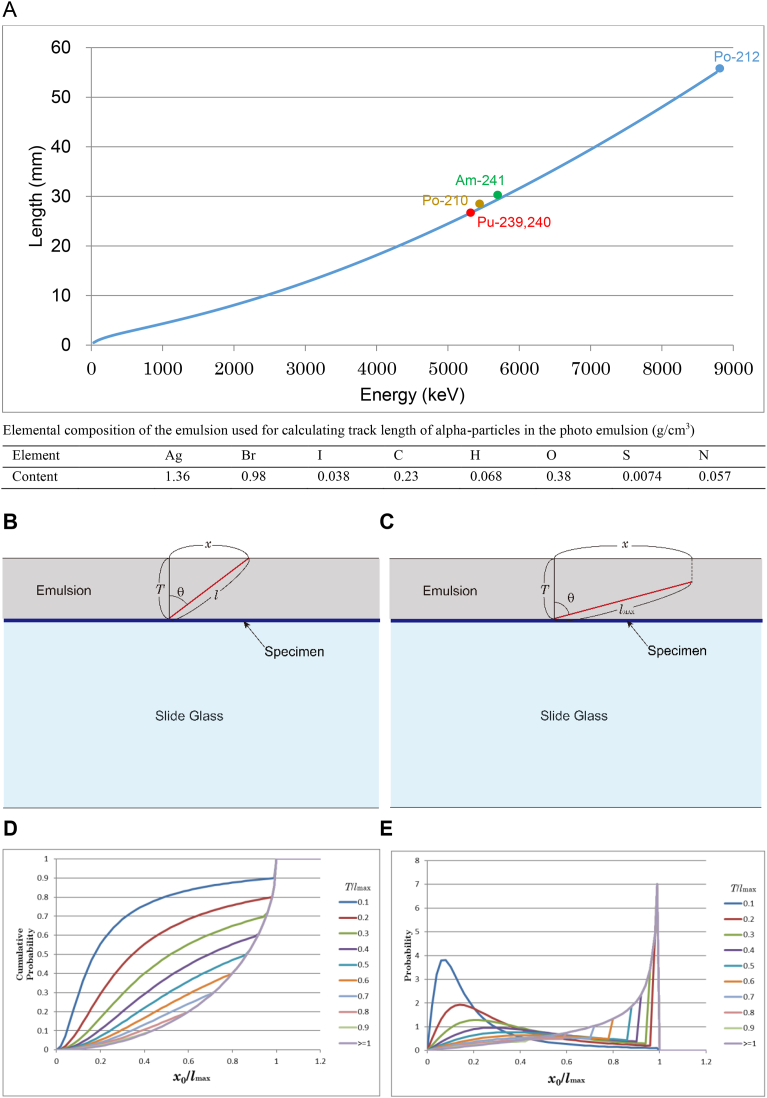
(A) Track length on photo emulsion calculated. (B) T<lMAX and x0<lMAX2−T2. (C) T≥lMAX or x0≥lMAX2−T2. (D) Cumulative probability Eq. (4) versus x0lmax . The value depends on Tlmax. (E) Differential probability of Eq. AP-4 versus x0lmax. The value was simply obtained through difference method. A sharp peak appears near x0lmax=1 when Tlmax is small.